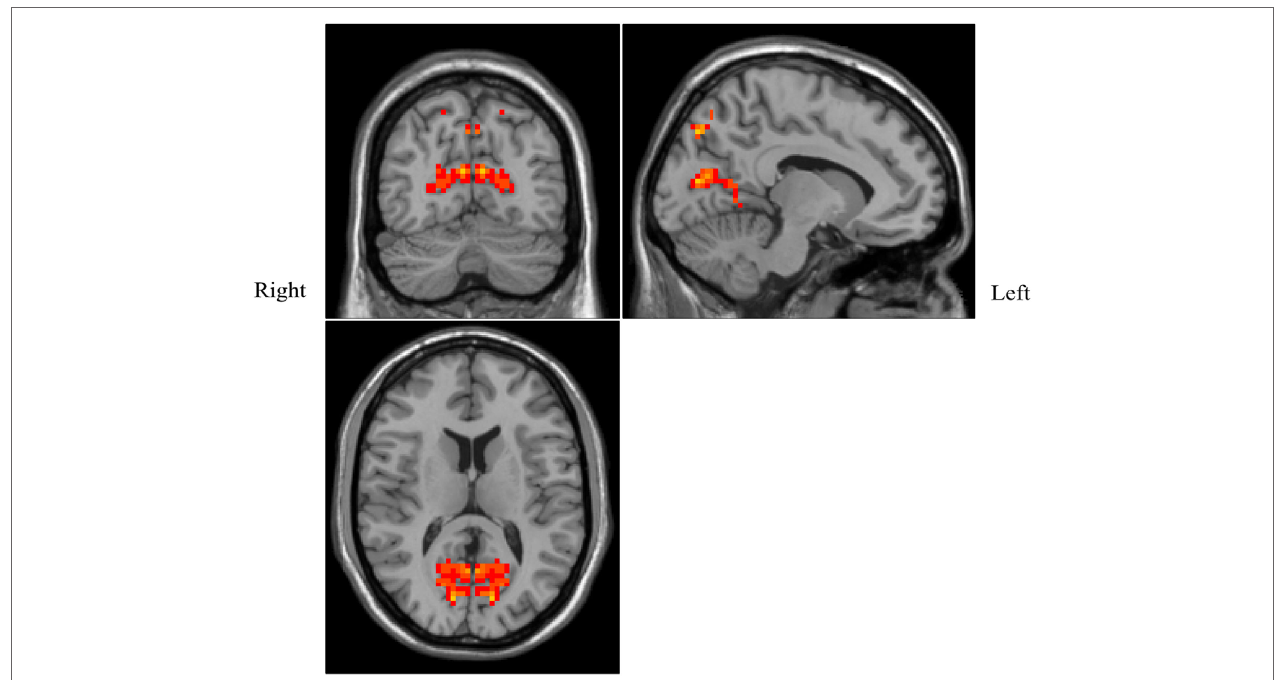
FigUre 2 | Shown is a significantly increased voxel-mirrored homotopic connectivity (VMHC) in obstructive sleep apnea–hypopnea syndrome patients as compared with controls. Thresholds are set at a corrected P < 0.05, as determined by Monte Carlo simulation. Red indicates increased VMHC. The left side of the images represents the right of the brain and vice versa .